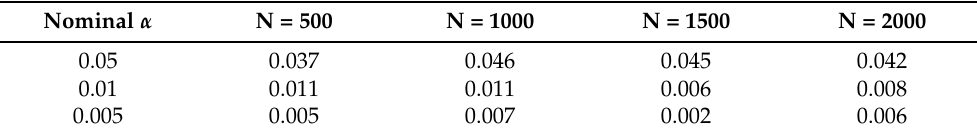
Table A2. Type I error simulation using cGFLM-ZINB for ZINB outcomes based on the CHRNA7